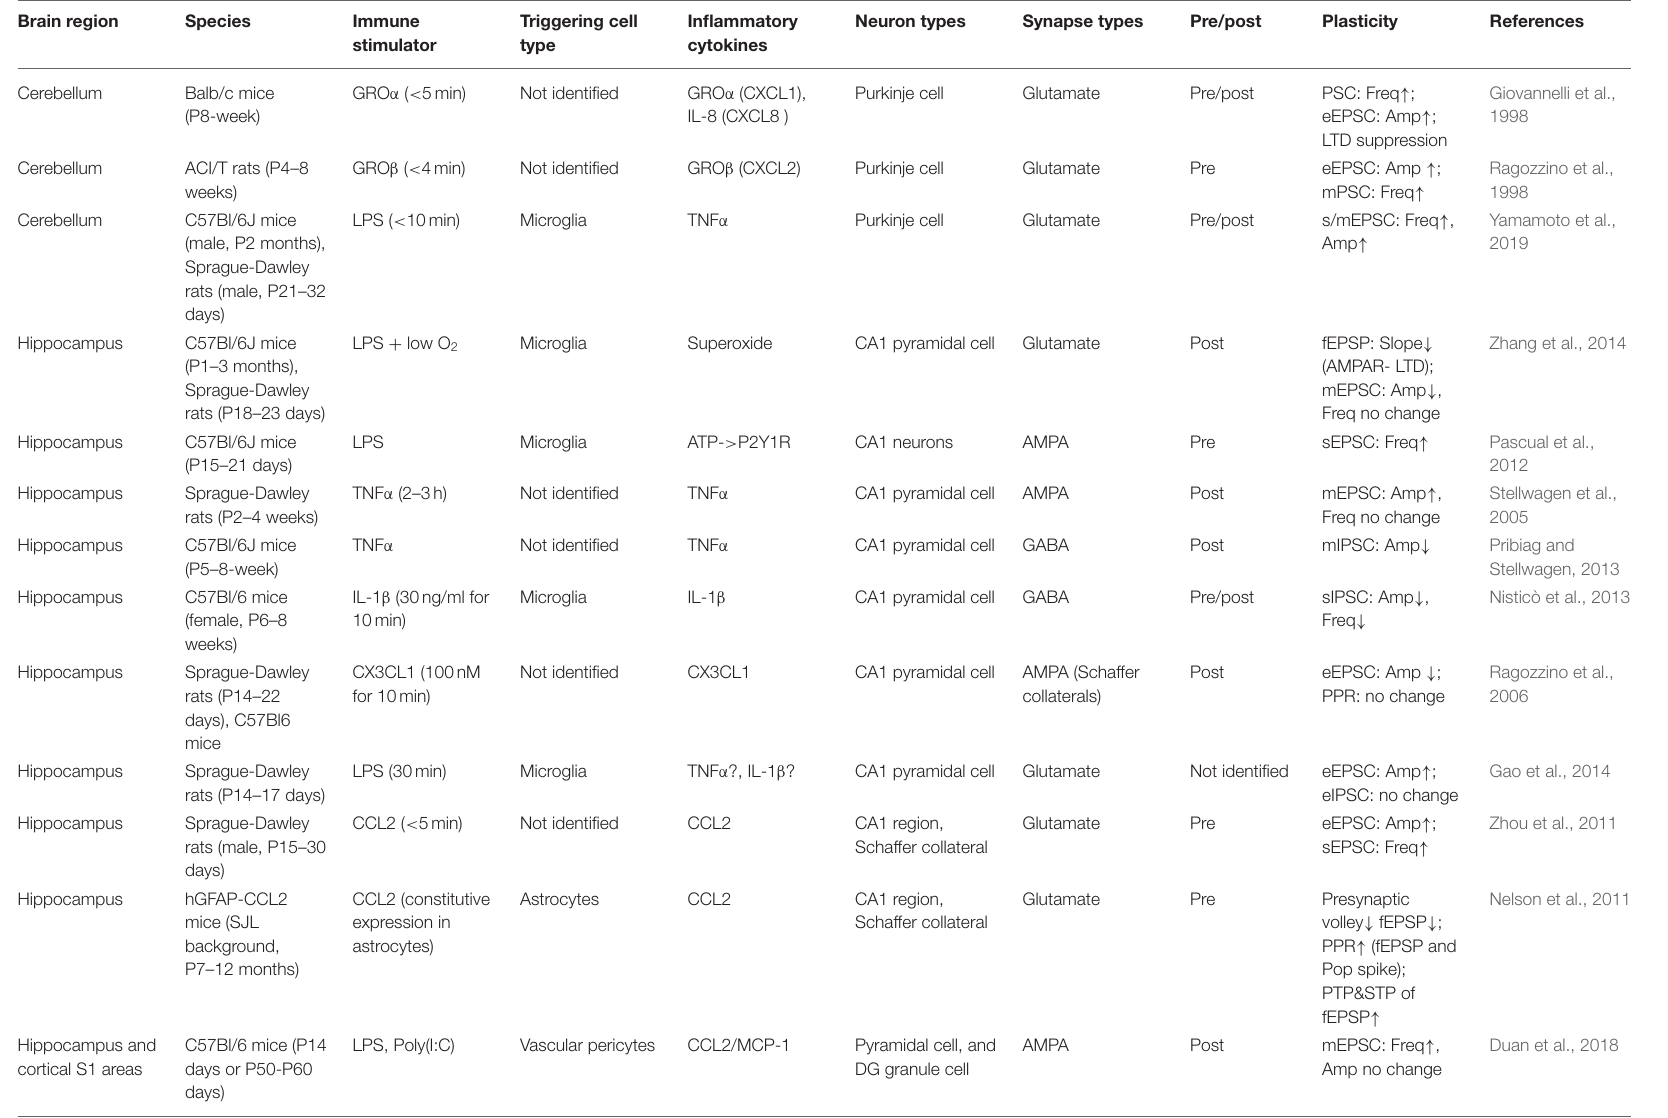
TABLE 1 | Immune-triggered modulation of the synaptic transmission of neurons. Brain